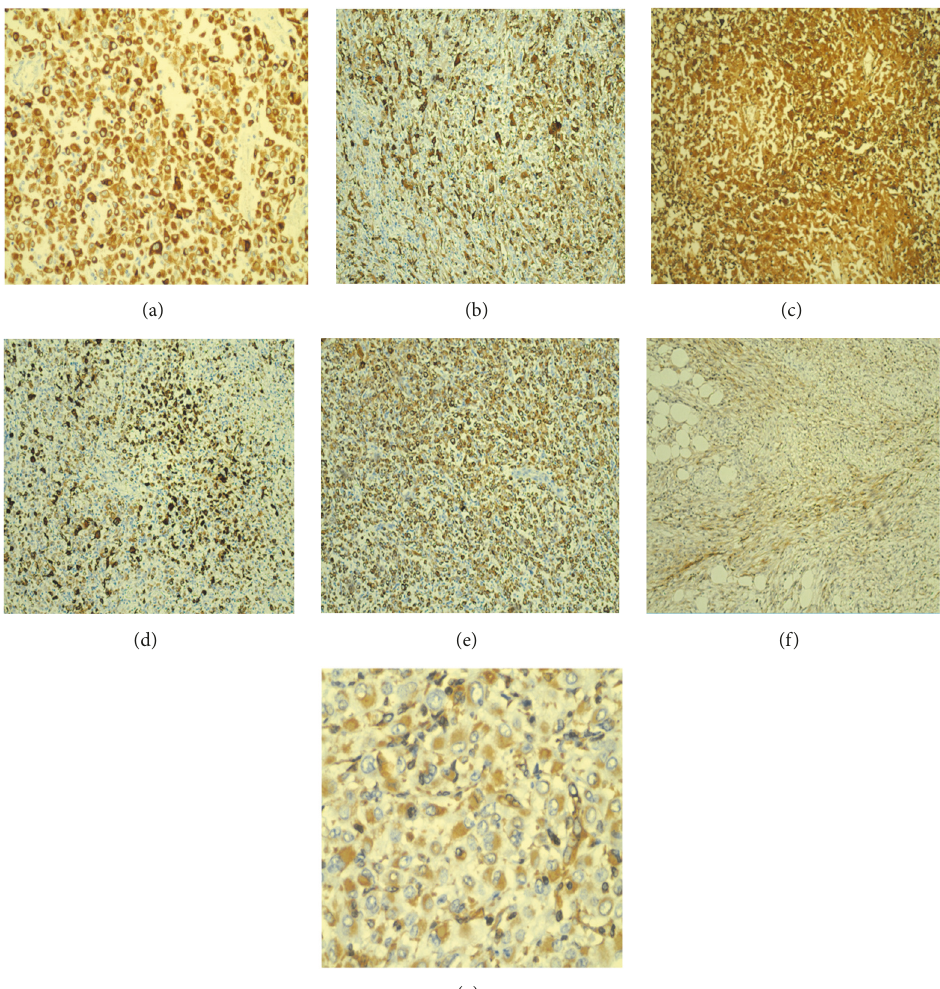
Figure 4: (a) AE1/AE3; (b) Calretinin; (c) CD10; (d) CDK53; (e) CK 5/6; (f) D2-40; (g)